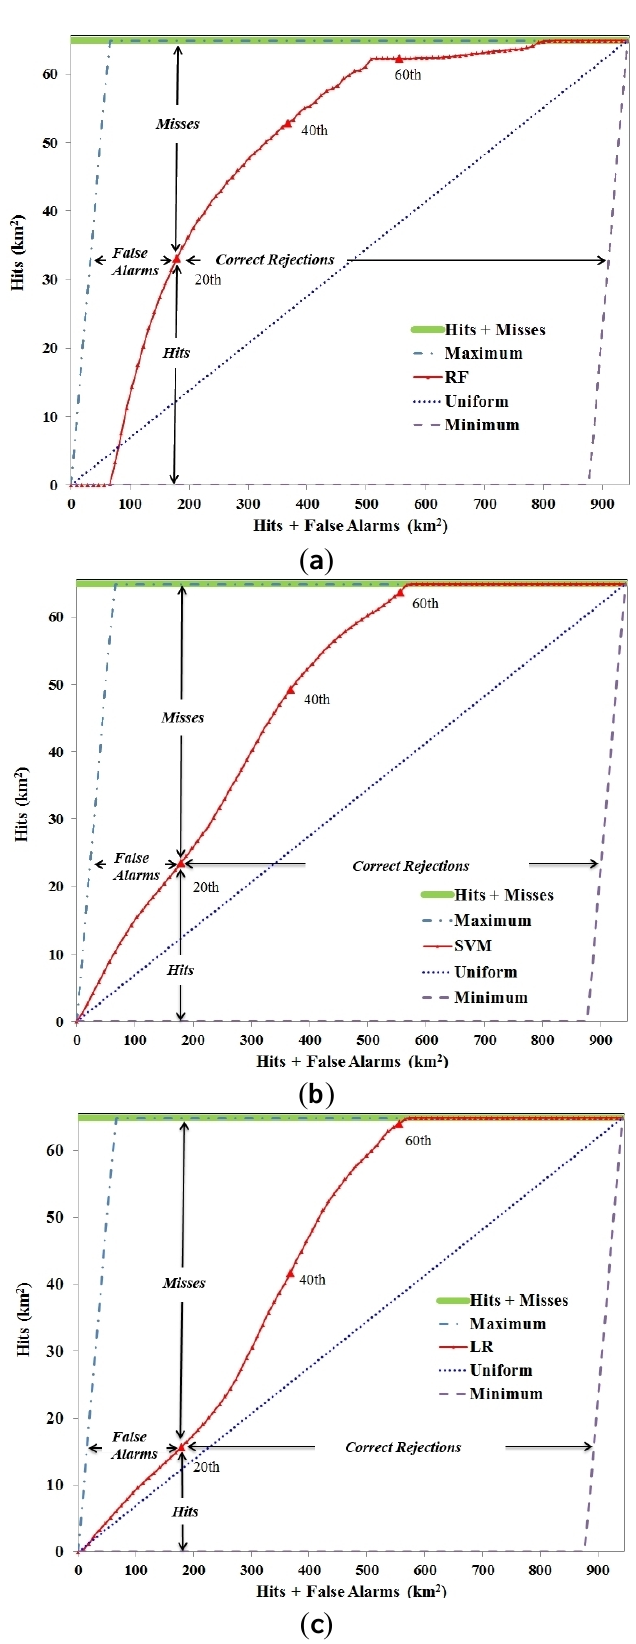
Figure 6. ( a ) Total Operating Characteristic (TOC) for the RF model; ( b ) Total Operating Characteristic (TOC) for the SVM model; ( c ) Total Operating Characteristic (TOC) for the LR